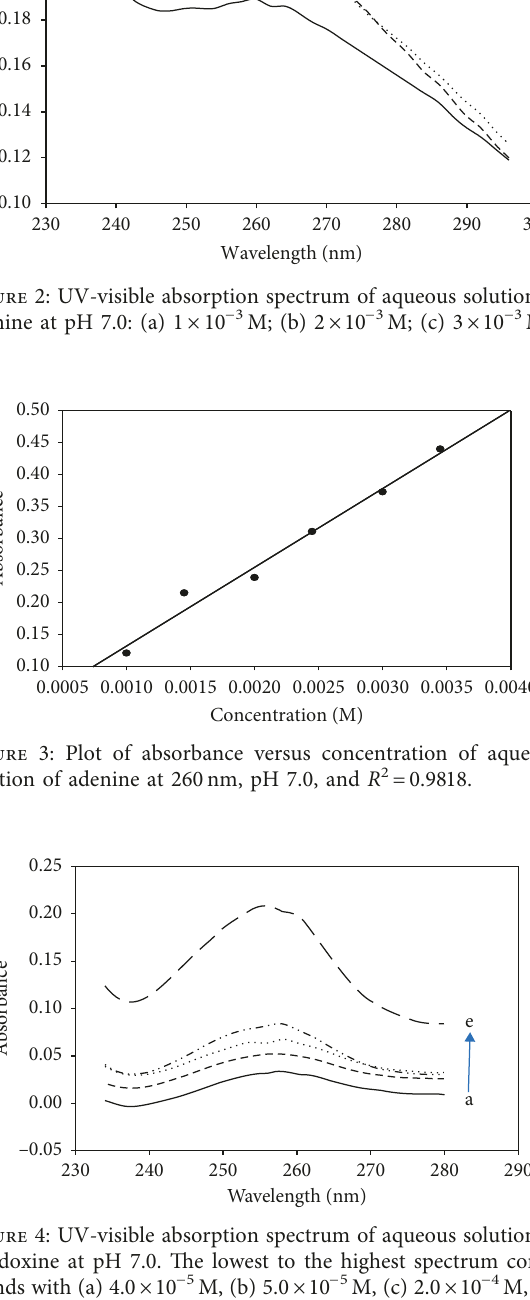
Figure 4: UV-visible absorption spectrum of aqueous solution of pyridoxine at pH 7.0. The lowest to the highest spectrum corre- 5 M, (b) 5.0 sponds with (a) 4.0 10 × × −